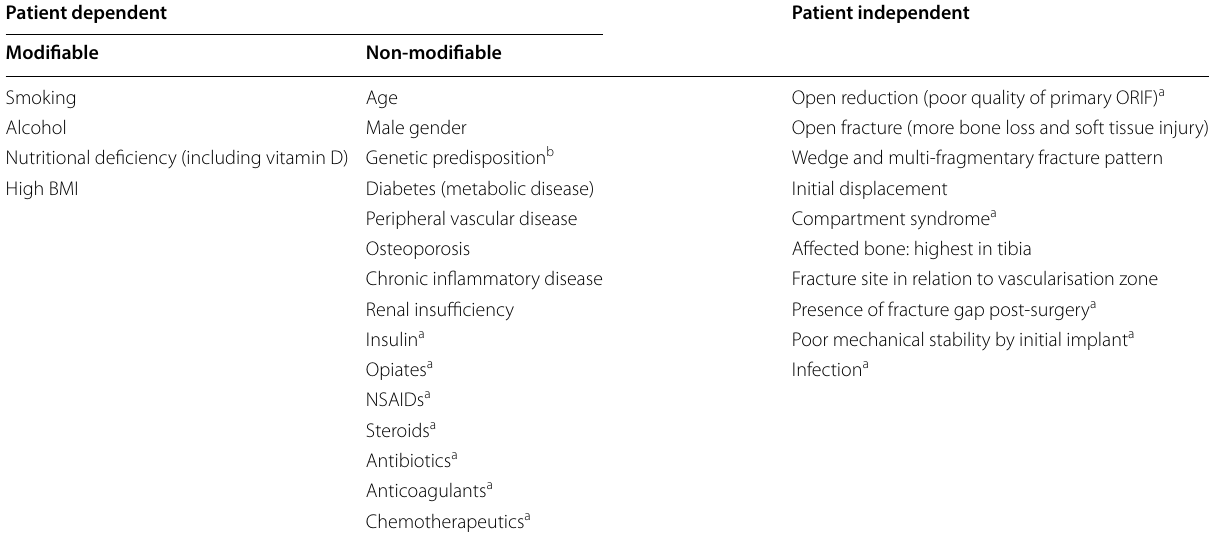
a Potentially modifiable, b Inconclusive—under